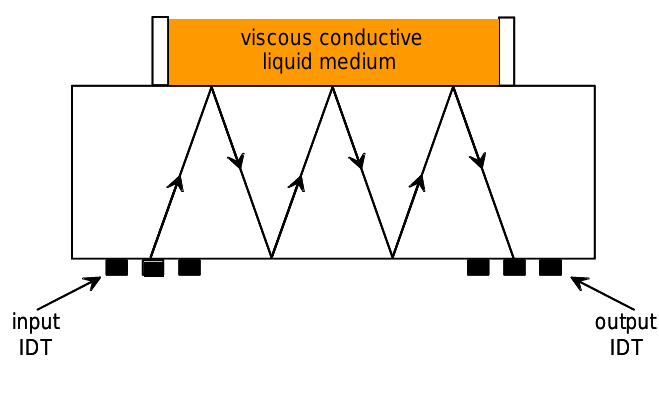
Figure 16. Structure of an SH-APM